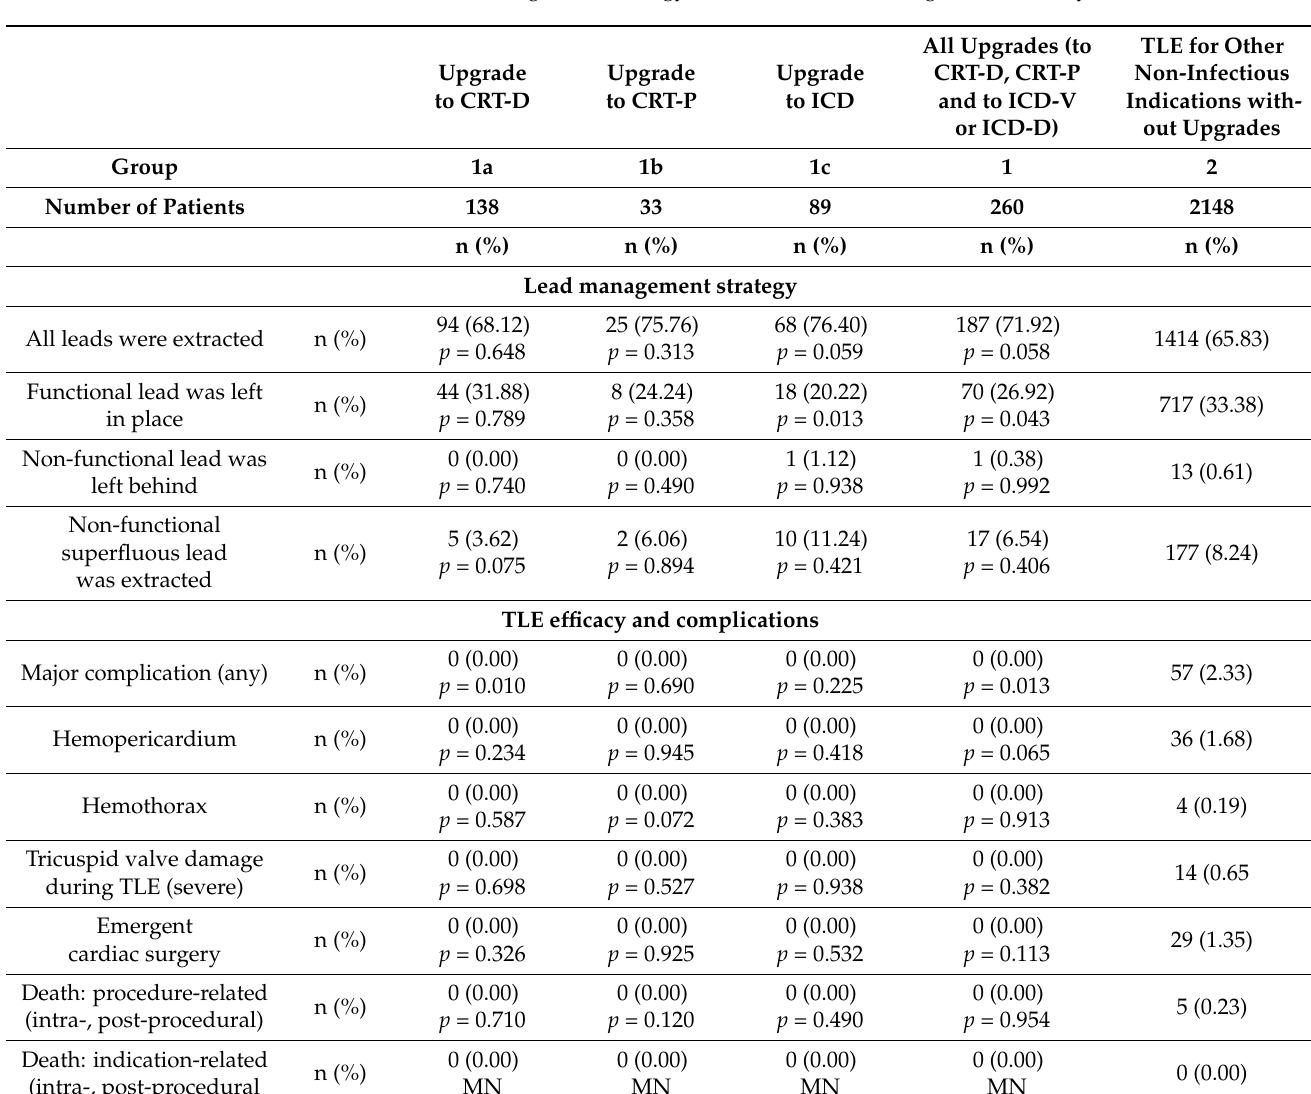
Table 4. Lead management strategy, TLE outcomes, and long-term